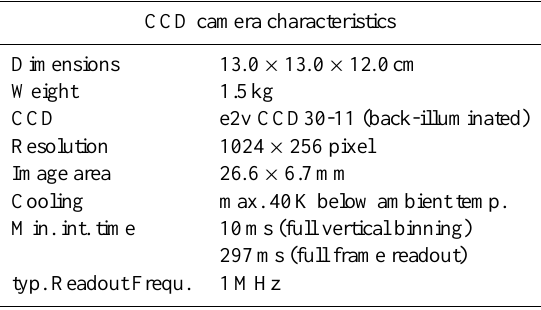
Table 3. Characteristics of HAIDI’s imaging spectrographs. Table 4. Characteristics of HAIDI’s custom-built CCD